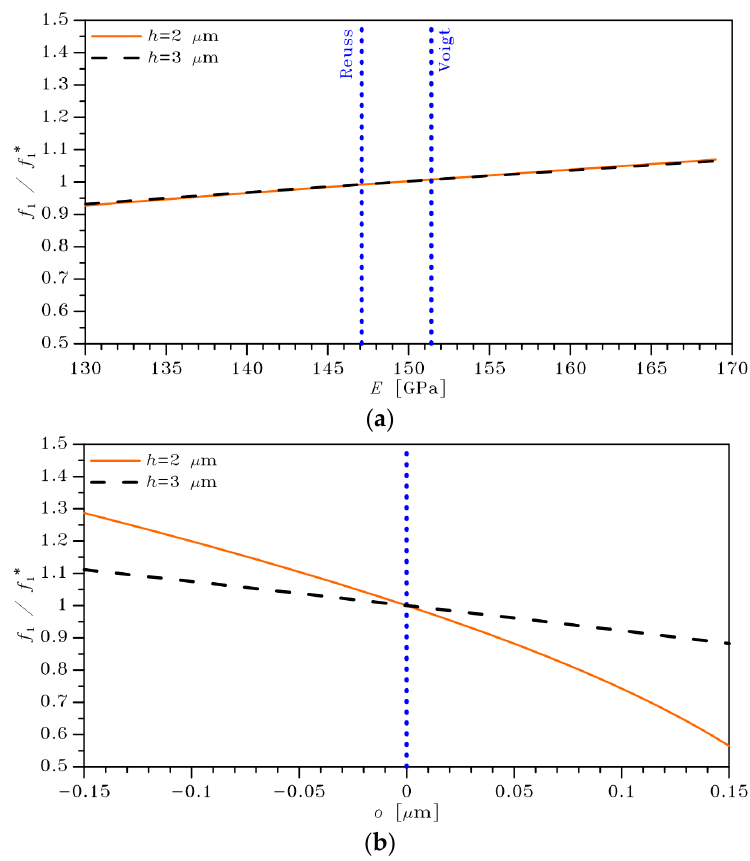
Figure 6. Sensitivity analysis: dependence of the natural frequency f 1 ( a ) on the polysilicon e ff ective Young’s modulus 𝐸 , and ( b ) on the over-etch depth 𝑜 .